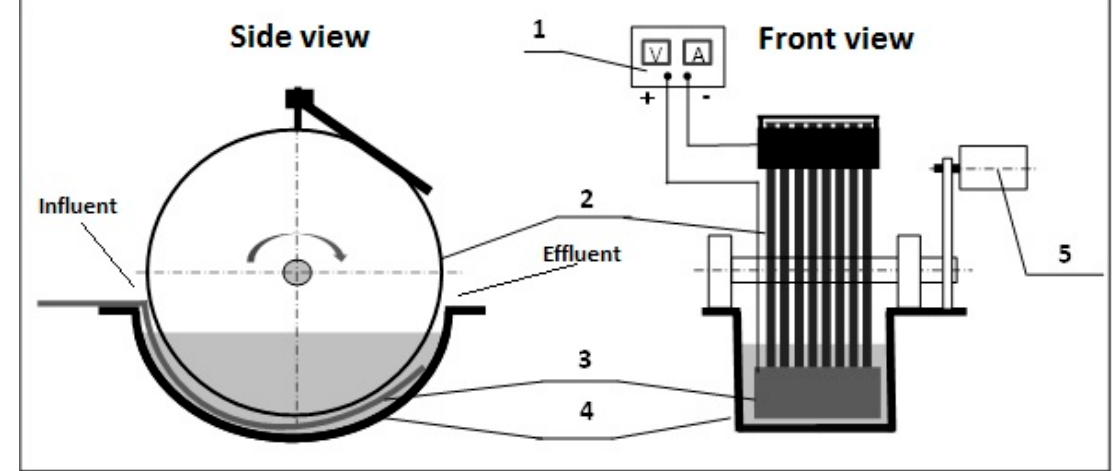
Figure 1. Scheme of an experimental model unit: 1—laboratory power supply, 2—disks (cathode), 3—anode, 4—tank, 5—electric engine [3].